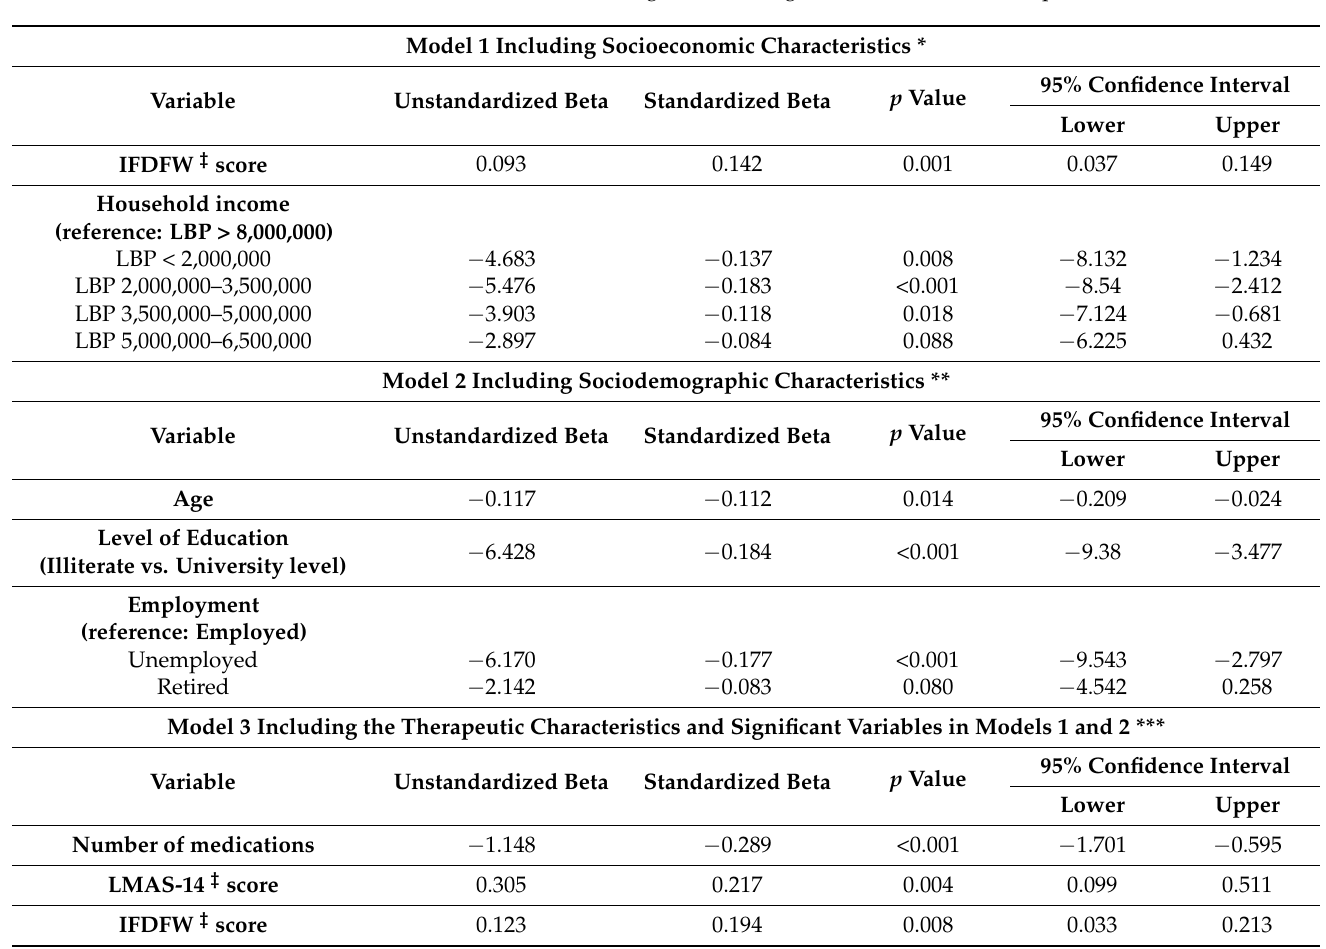
Table 6. Multivariable linear regression taking the SS-QOL-17 as the dependent